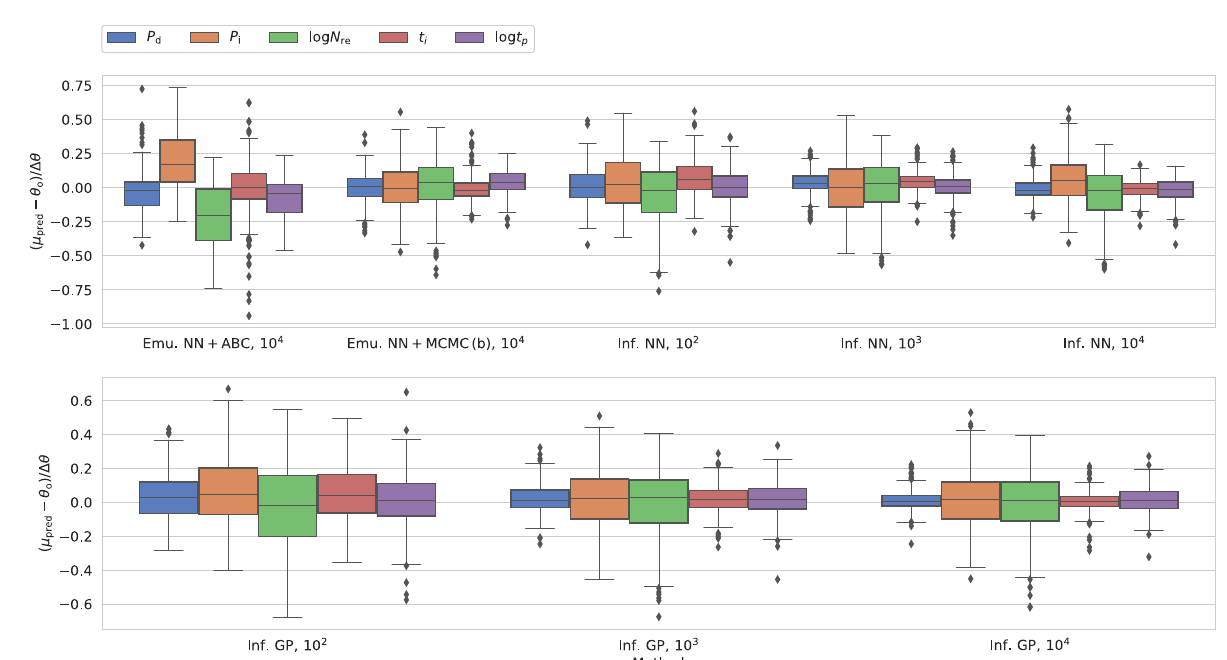
Fig 5. Counterpart to Fig 4 for our epidemiological SIRDS model. Here, we show the performance across different inference schemes for our SIRDS model in terms of the residuals between the mean of the marginal distribution and the true parameter values ( θ o ) in units of the width of the observed parameter range ( Δ θ ). In contrast to Fig 4, we scale the residuals based Δ θ because the different parameters cover very different ranges. For other metrics, we refer the reader to S10